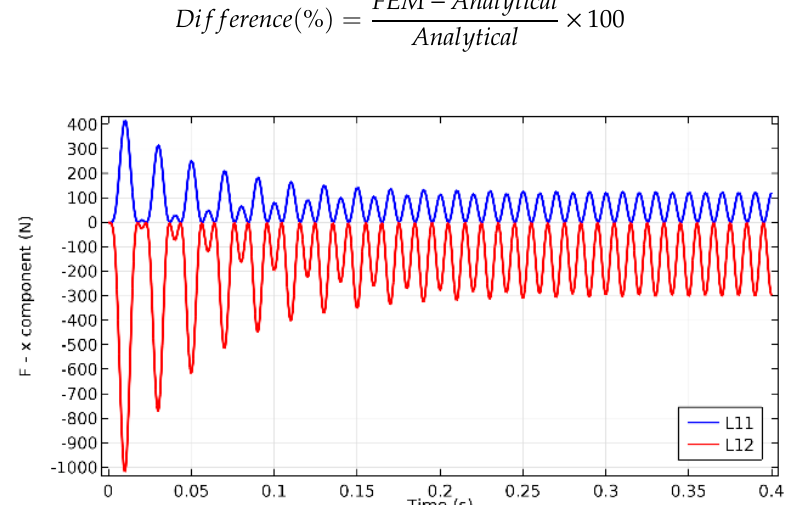
Figure 11. Electrodynamic forces on earthing knifes L11 and L12 obtained by finite element method (FEM) calculation.